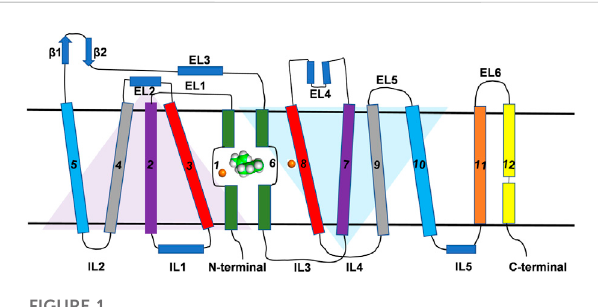
FIGURE 1 Topological representation of DAT. The TM helices, intracellular loops and extracellular loops are labeled. The orange spheres represent the Na + ions. Green and white spherical model represents the substrate molecule. Two inverted triangles represent the two domains with an inverted axis of symmetry that contributes to substrate binding